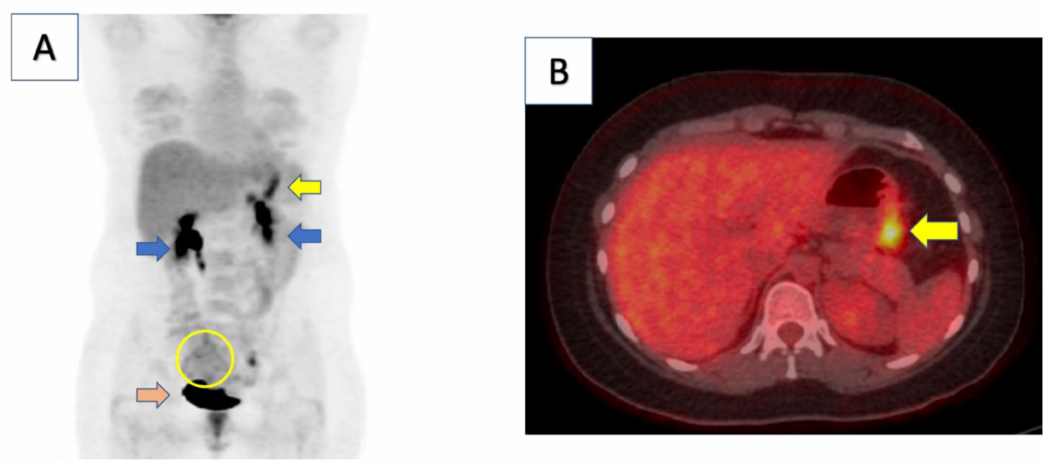
Figure 1. Computed tomography (CT)/positron emission tomography (PET) scan of patient demon- strated moderate focal uptake along gastric body consistent with known malignancy (yellow arrow in panel ( A , B )). There was also a large, mildly hypermetabolic right adnexal area with heterogenous uptake concerning for metastatic involvement (yellow circle). Kidneys (blue arrows) and bladder (orange arrow) demonstrate physiologic